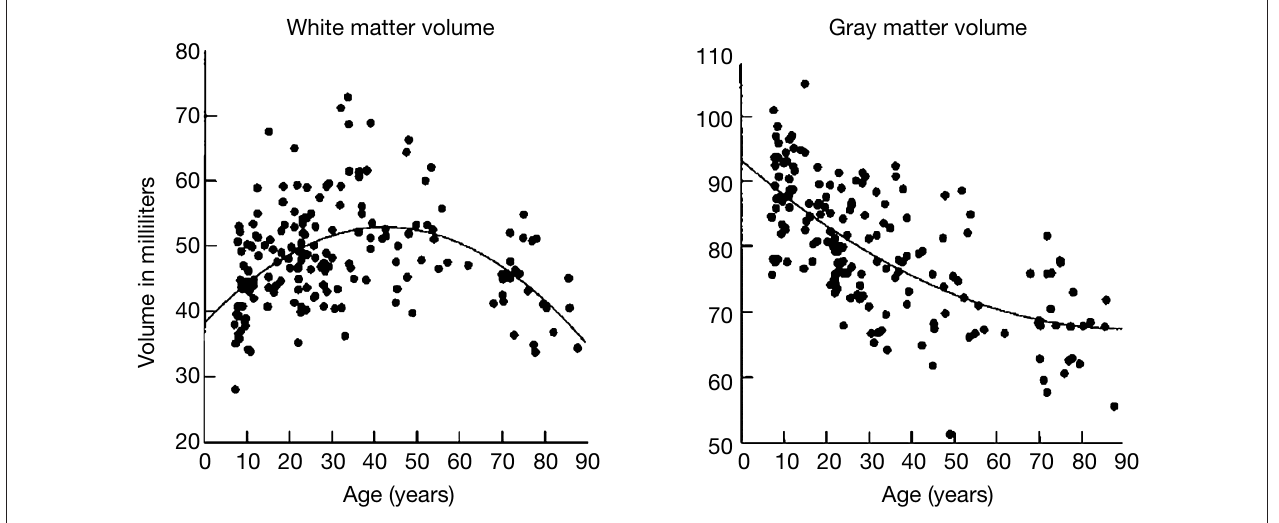
FIGURE 4 | Grey matter and white matter volumes in healthy subjects assessed with MRI. From Sowell et al. (2003), with